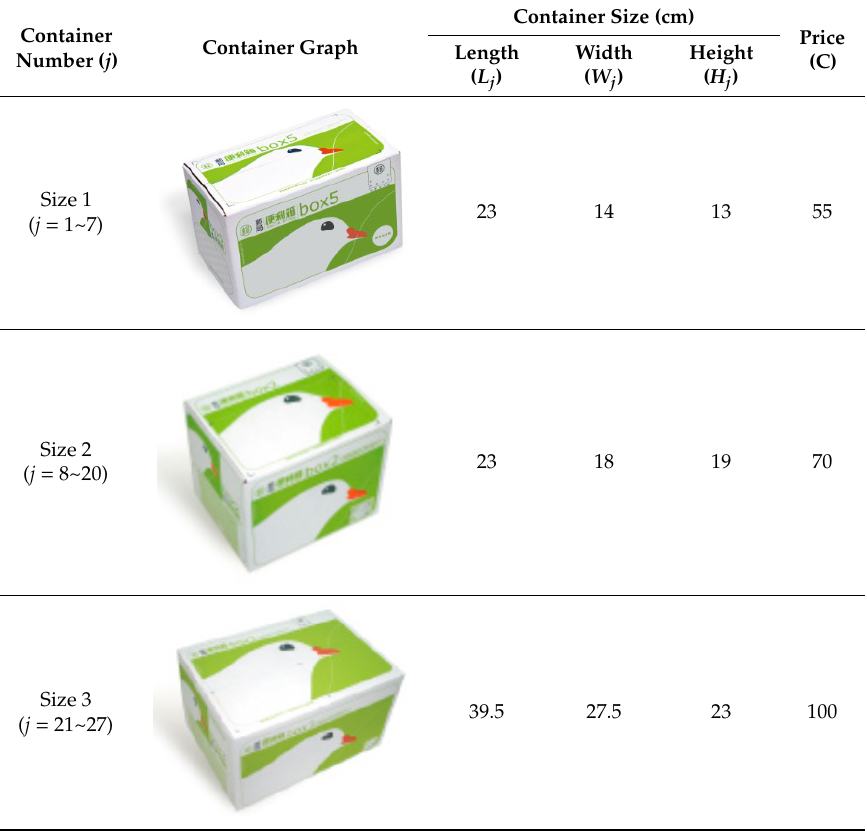
Table 3. The sizes and price of three kinds of containers.